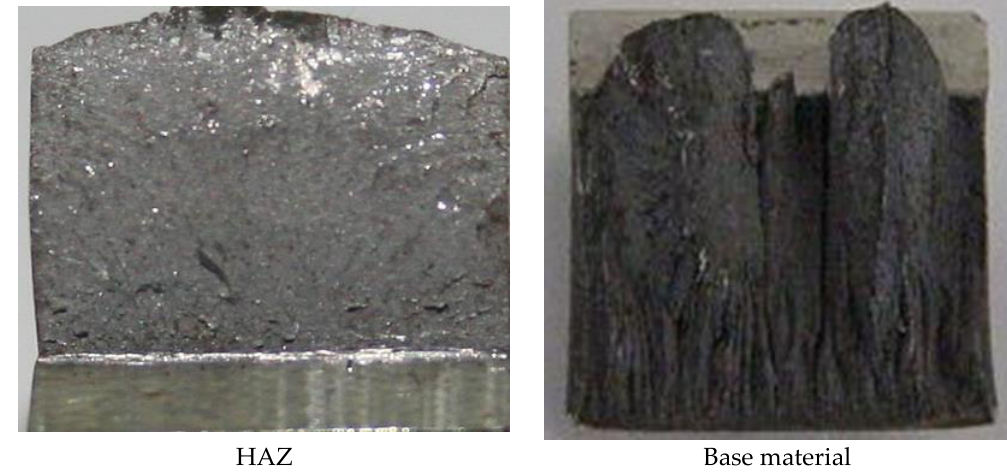
Figure 11. Fractures after the impact test of the S700MC steel laser welded joints in the PC position.